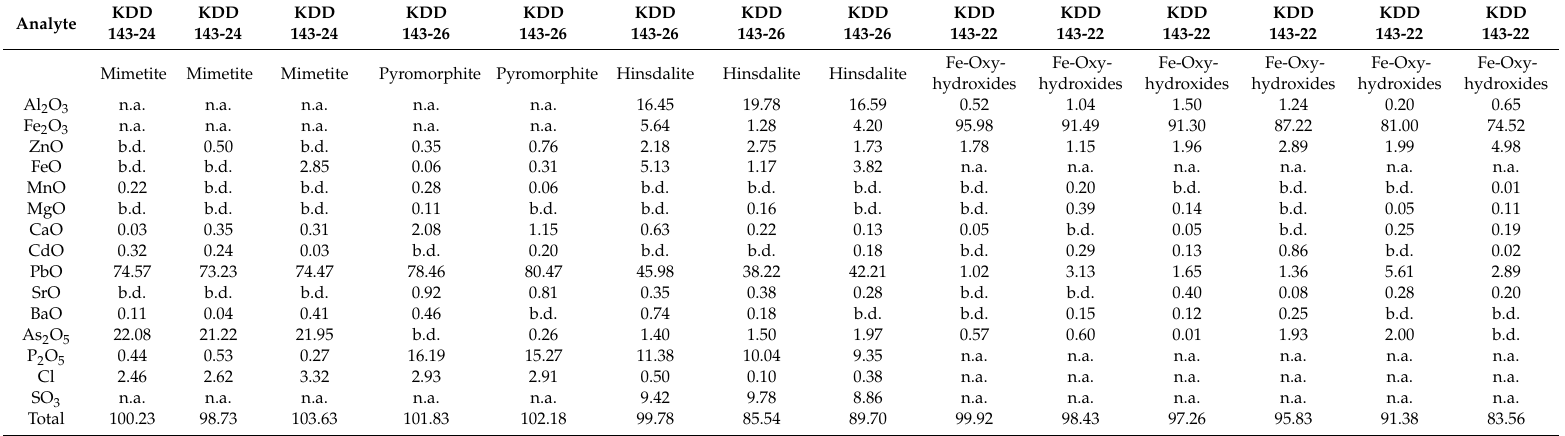
Table A3. Representative chemical composition (SEM-EDS) of miscellaneous minerals detected in the Kihabe nonsulfide associations.